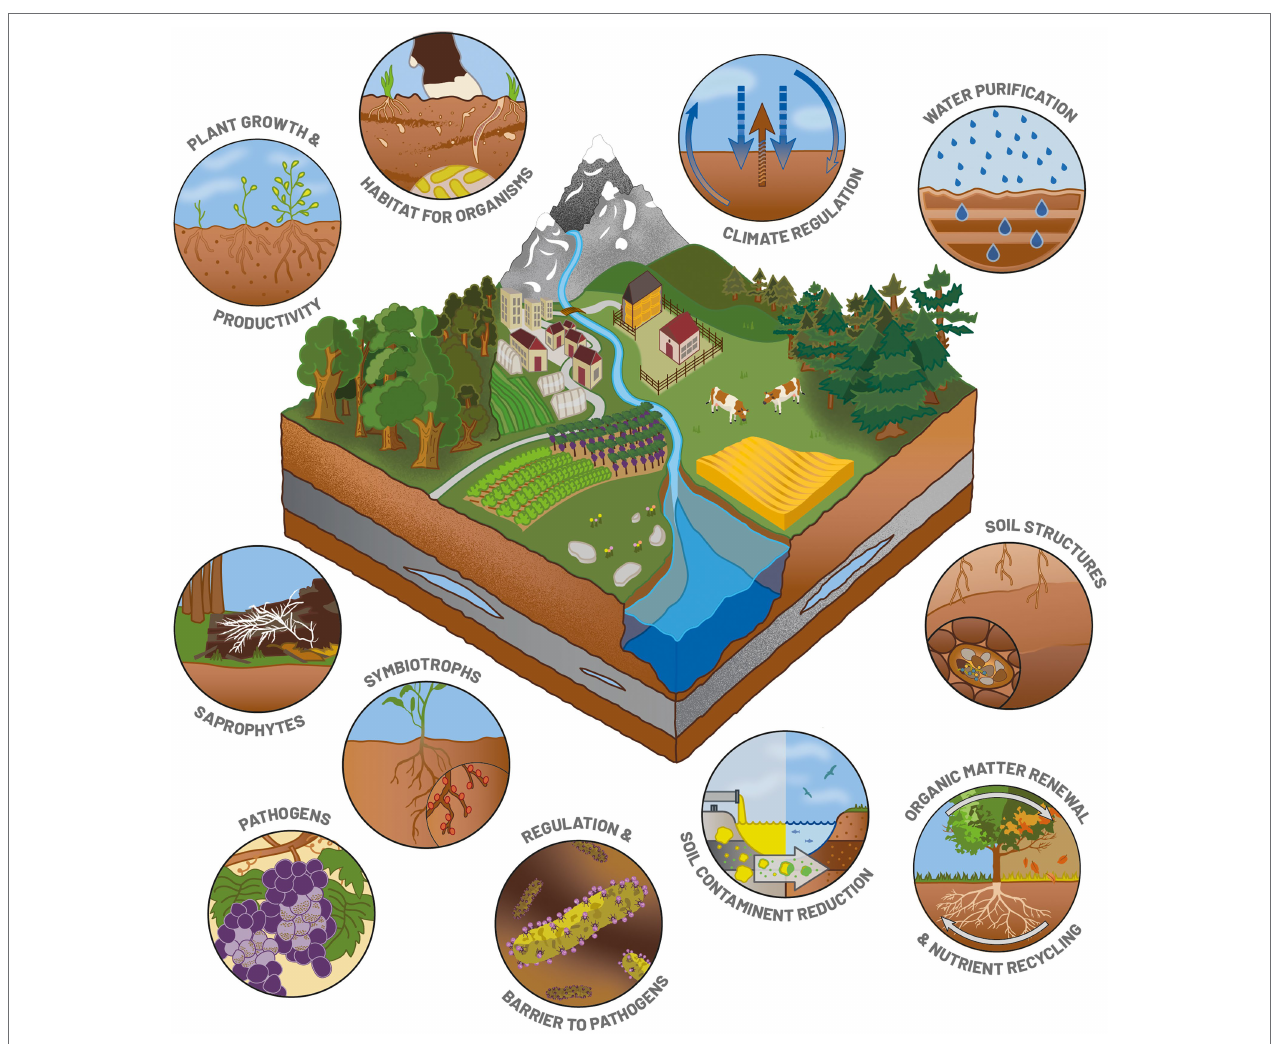
FIGURE 1 | Illustration of the main roles of soil functions and microorganisms as essential players in various ecosystem